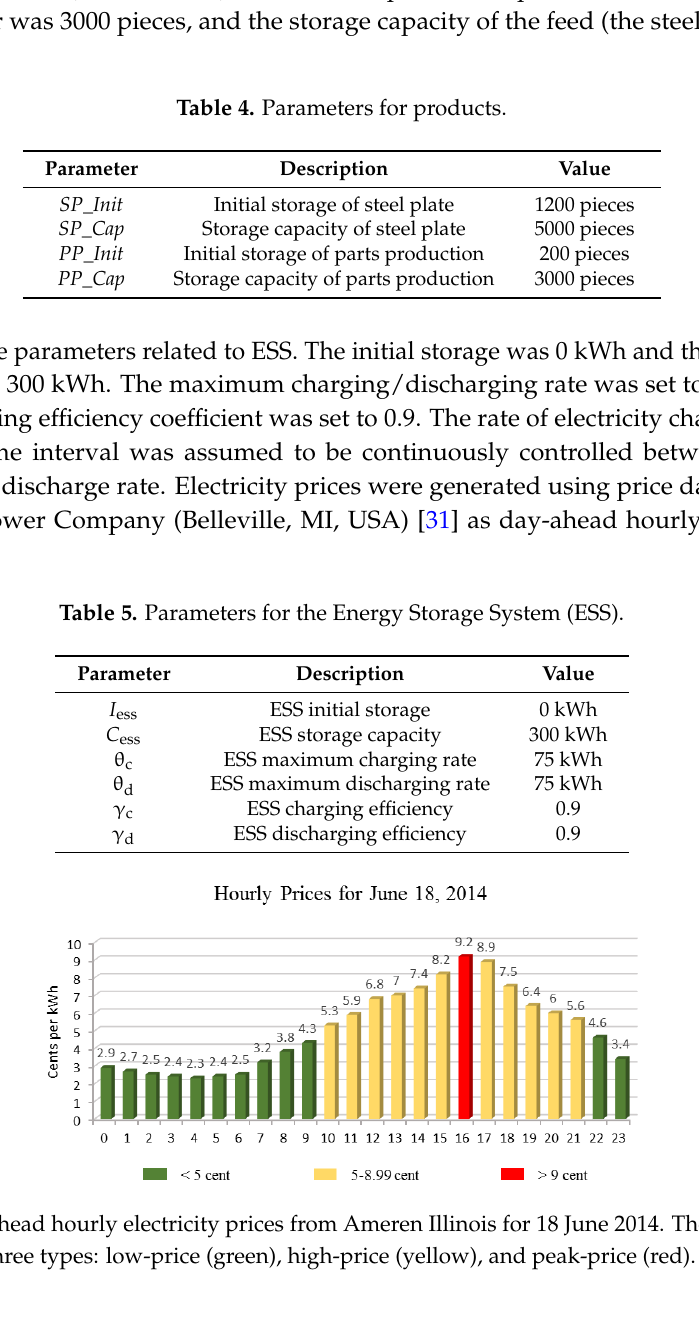
Table 4. Parameters for products.